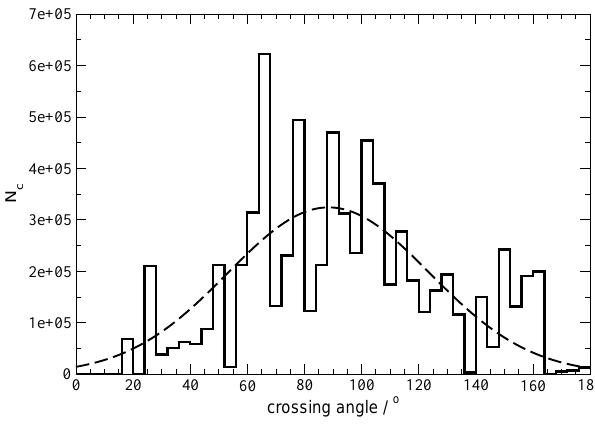
Fig. 7. Vertical distribution of intersection points for different ele- vation cut-off angles 0 ◦ ≤ ε min ≤ 10 ◦ . N c is the number of intersec- tion points in a 167m vertical interval.